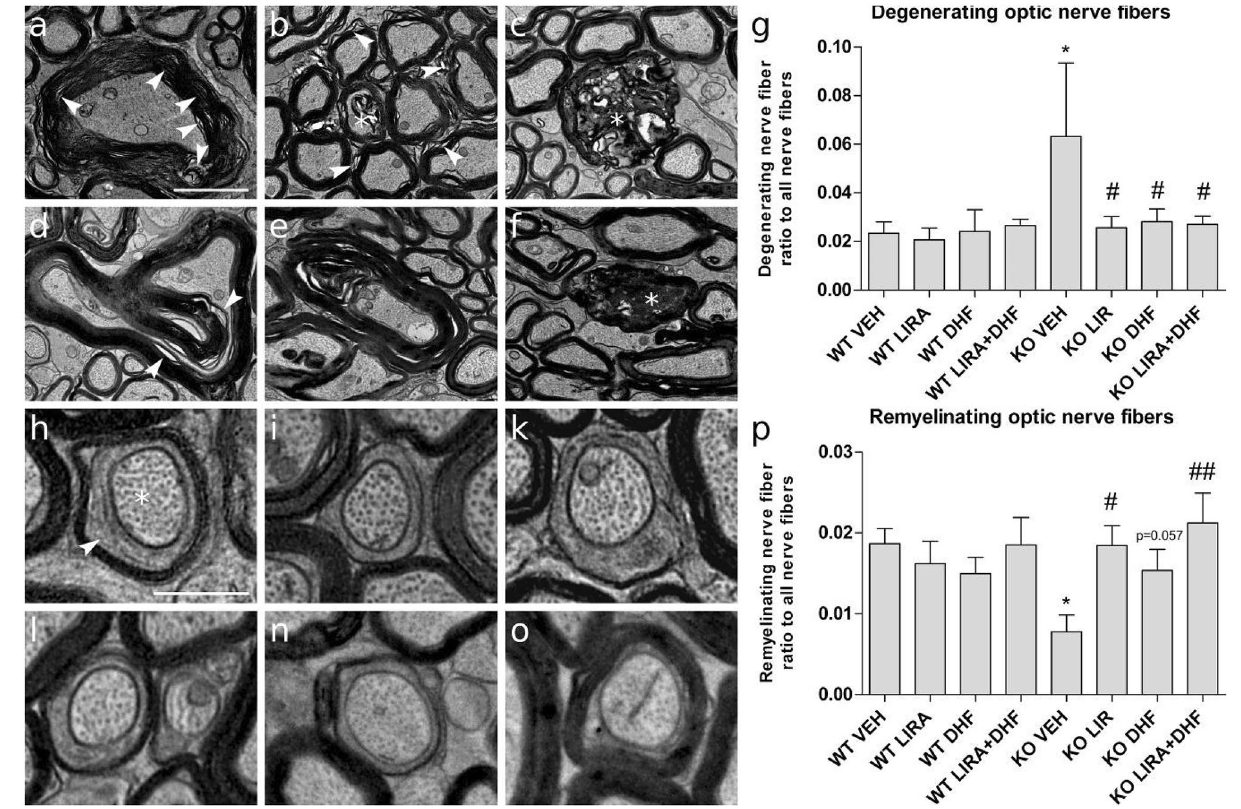
Figure 4. 3.5-month treatment with liraglutide, 7,8-DHF or liraglutide and 7,8-DHF prevents optic nerve fiber degeneration and induces remyelination. ( a – f ) Wfs1 KO VEH axons with several pathological features. ( a , b , d ) intense myelin damage is observable as lamina decompaction in small and large caliber axons (arrowheads). ( d , e ) axon compression accompanies myelin lamina decompaction. ( b , c , f ) nerve fibers show severe myelin disruption coinciding with features of axonal degeneration (asterisks). ( g ) Ratio of degenerating fibers to all counted fibers from corresponding treatments. ( h – o ) Images illustrate analyzed remyelinating axons (asterisk) where compacted myelin sheath is observable (arrowhead). ( p ) Ratio of remyelinating optic nerve fibers to all counted fibers from corresponding treatments. Quantitative data were compared using factorial ANOVA followed by Fisher’s LSD tests; *p < 0.05 compared to WT vehicle animals and # p < 0.05; ## p < 0.01 compared to KO Sal animals. The data are presented as the mean ± SEM, n = 4–7 per group. Scale bars: ( a – f ) 2 μm; ( h – o ) 1 ratio of degenerating optic nerve fibers compared to vehicle treated Wfs1 KO animals (p < 0.05) which indicates a protective effect of all treatments (Fig. 4g). In order to quantify remyelinating axons, the optic nerve fibers must display the following distinctive features: few myelin lamellae and the large inner tongue process containing decompacted myelin 15 as presented on Fig. 4 micrographs h–o. In WT animals, the ratio of remyelinating fibers stayed relatively constant between different treatments (Fig. 4p). Vehicle treated Wfs1 KO rats optic nerves display a significantly lower ratio of remyelinating axons compared to WT animals (p < 0.05) (Fig. 4p). Liraglutide treatment increased remyelinating optic nerve fibers in Wfs1 KO animals when compared to vehicle treatment (p < 0.05) (Fig. 4p). 7.8-DHF treatment also tend to increase remyelinating optic nerve fibers in Wfs1 KO animals (p = 0.057) (Fig. 4p). The co-treatment with lira- glutide and 7,8-DHF increased remyelinating optic nerve fibers at most in Wfs1 KO animals (p < 0.01) (Fig. 4p). Wfs1 KO rats show impairment in learning. In Morris water maze experiment, during training ses- sion Wfs1 KO rats needed more time to reach the platform as compared to WT rats (p < 0.01) (Fig. 5a). In WT animals drug treatment had no effect on the performance (Fig. 5d). Time to reach the platform was decreased in 7,8-DHF treated Wfs1 KO animals compared to vehicle treated Wfs1 KO animals during training session (p < 0.01, Fig. 5g). In agreement with an increased time to reach the platform during training session, Wfs1 KO rats spent also less time in the target quadrant as compared to WT rats (p < 0.01) (Fig. 5b). Drug treatments had no effect on the percent of time spent in the target quadrant during training phase in rats of both genotypes (Fig. 5e,h). There were no statistically significant changes in the swimming speed during the training session of Morris water maze experiment regardless of genotype and treatment (Fig. 5c,f,i). On the probe day of Morris water maze, Wfs1 KO rats from the vehicle group spent more time searching for the platform as compared to WT vehicle treated rats (p < 0.05) (Fig. 5j). Liraglutide, 7,8-DHF or their combination improved Wfs1 KO animals’